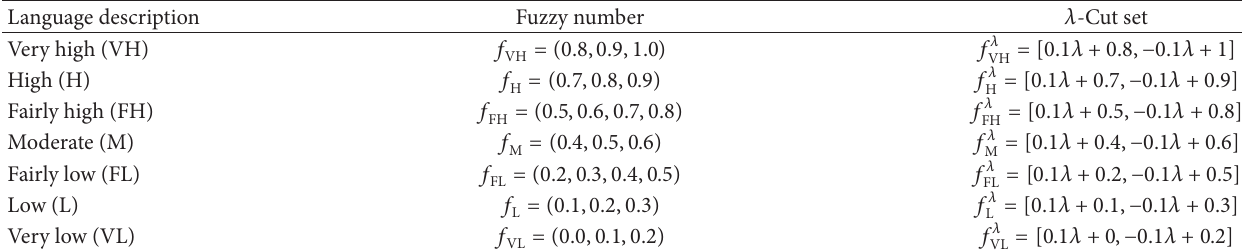
Table 1: Fuzzy number and 𝜆 -cut